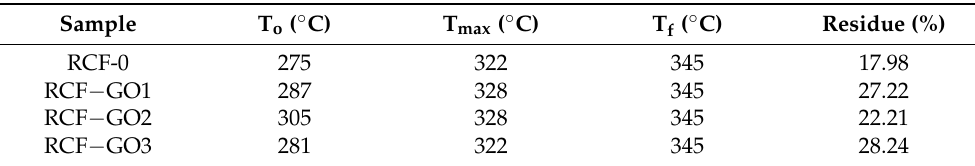
Table 2. Thermal degradation of